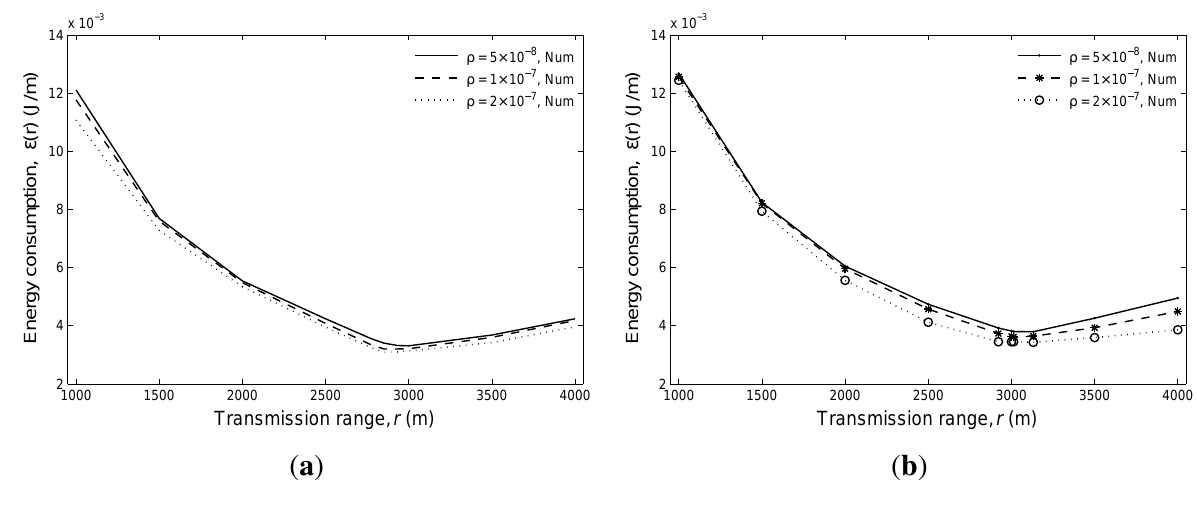
Figure 3. The numerical results of the average energy consumption versus the transmission range. ( a ) a = 5 , 000 m; ( b ) a = 10 , 000